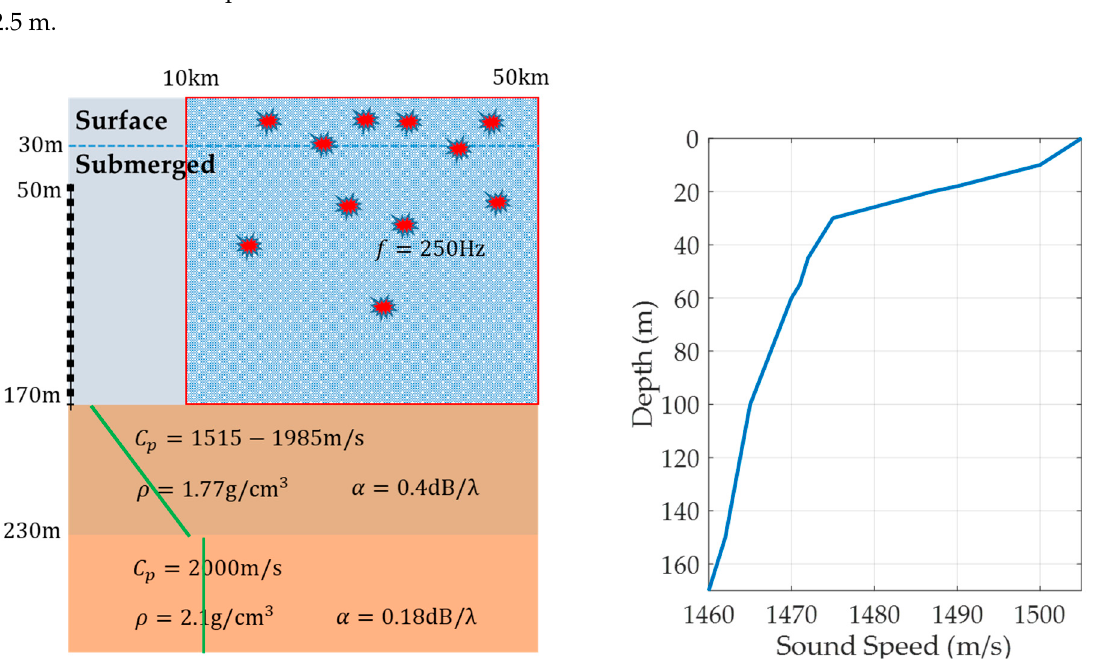
Figure 5. Shallow water environment of MAPLE4 experimental site ( right figure). Red symbols represent random positions of targets in the ocean. The left figure shows an ocean environment with a vertical line array. The right figure is the sound speed profile.